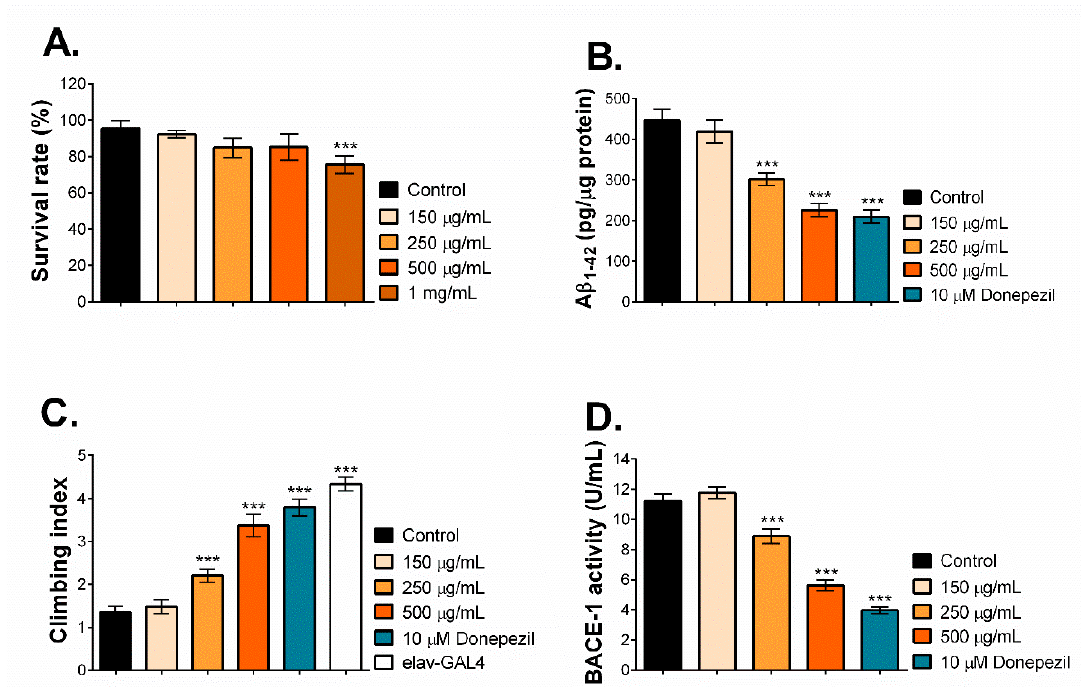
Figure 2. ( A ) Determination of safe doses of MNCM extract in fly larvae, the third-instar larvae were fed with MNCM extract (150 µ g / mL–1 mg / mL). The surviving flies were counted within 5 days after the first eclosion and the percentage of the survival rate was calculated. ( B ) E ff ects of MNCM extract on the accumulation of A β 1–42 peptides in fly brains. Flies were treated with MNCM extract (150–500 µ g / mL) for 28 days, and after that fly heads were lysed and subjected for ELISA. ( C ) E ff ects of MNCM extract (150–500 µ g / mL) on the locomotory coordination (climbing) of AD flies after 28 days of treatment. ( D ) E ff ects of MNCM extract on the BACE-1 activity in fly brains. Flies were treated with MNCM extract (150–500 µ g / mL) for 28 days, then fly heads were lysed and subjected for BACE-1 activity determination. The data are representative of three replicates and show mean ± standard deviation (SD). The one-way ANOVA followed by Tukey’s test was used to determine the di ff erences between groups. ***, p < 0.001.